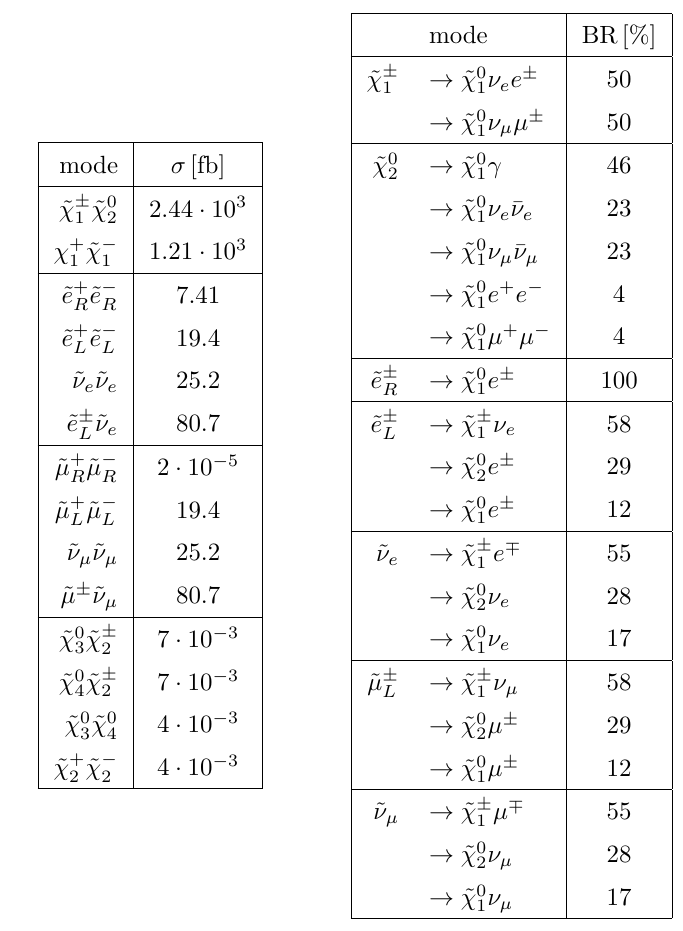
Table 2 . The NLO production cross-sections at the 13 TeV LHC and branching ratios of light sparticles for